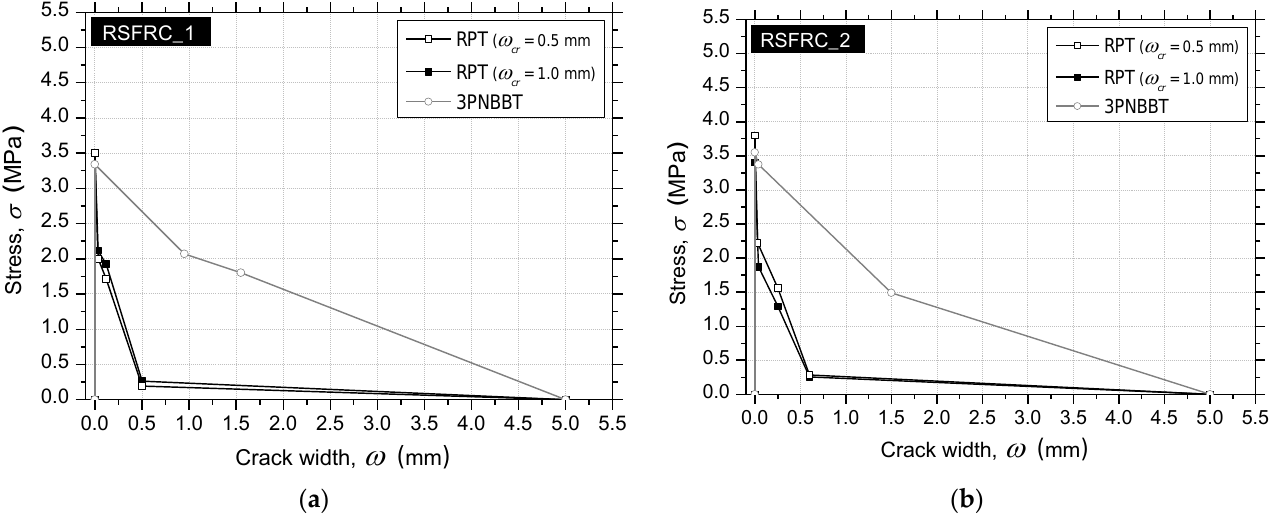
Figure 18. Stress–crack width ( σ − ω ) relationships obtained by inverse analysis from RPT-3ps and 3PNBBT for: ( a ) RSFRC_1 batch ( b ) RSFRC_2